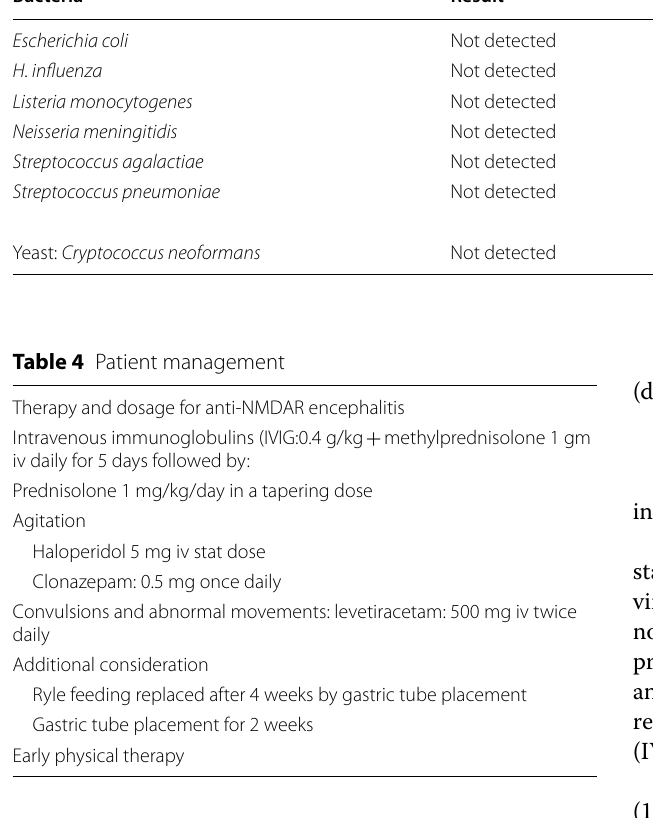
Table 3 Meningitis/encephalitis panel by Biofire Film Array (Multiplex PCR) Bacteria